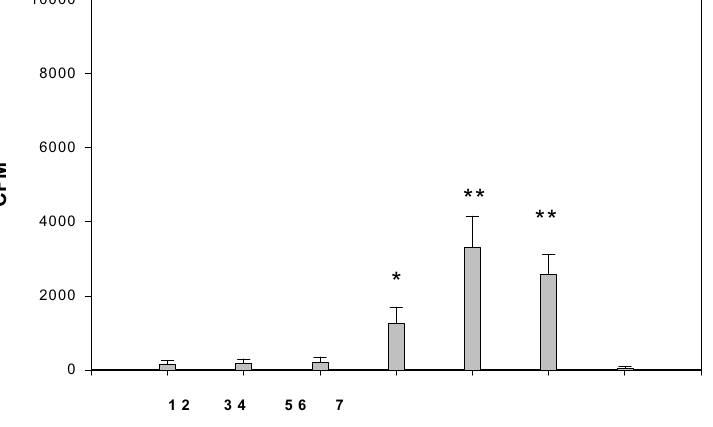
Figure 7 Quantification of [ γ 32-P] GTP bound to cyclase complex A: Quantification [ 32 yP- GTP] in cyclase(s) complex at t = 0. Membranes (50 µ g protein) were incubated with [ γ 32-P] GTP and isoproterenol , isoproterenol + baclofen or baclofen (each 200 nM) in presence of EDTA (1 mM) for 20 min at 20°C. The membranes were then placed in ice and solubilized, and the cyclase(s) complex was isolated by Forskolin-agarose. The radioactivity in the isolated 'pull down' was measured by filtra- tion on nitrocellulose membrane. Bars represent the mean +/-SE of 3 experiments. Control experiments with only membrane, CTx or PTx treated membrane are also shown. Lane 1 : control membrane, lane 2 : iso , lane 3 : bac , lane 4 : iso + bac , lane 5 : iso + bac + CTx , lane 6 : CTx , lane 7: PTx B: Quantification [ 32 yP-GTP] in cyclase(s) complex at t = 5 min. [ γ 32 -P] GTP bound to cyclase(s) complex was measured 5 min after a large excess of GTP was added. Membranes were incubated as indicated above, placed in ice and complemented with Mg (5 mM) for 5 min, then solubilized in the presence of NaF (100 µ M). The cyclase(s) complex was isolated as above. The radioactivity in the isolated 'pull down' was measured by filtration on nitrocellu- lose membrane. Bars represent the mean +/-SE of 3 experiments. * p < 0.01 and ** p < 0.005 Lane 1 : control membrane, lane 2 : iso , lane 3 : bac , lane 4 : iso + bac , lane 5 : iso + bac + CTx , lane 6 : CTx , lane 7: